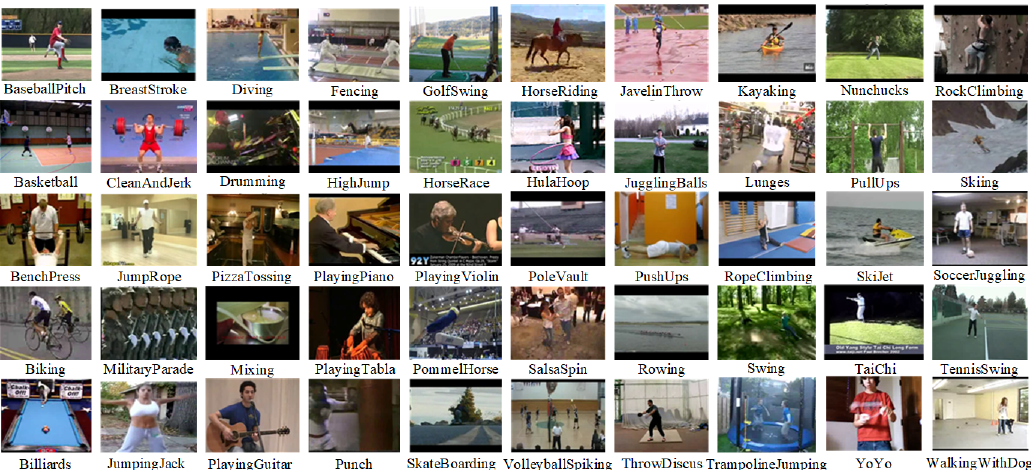
Figure 6. Example of the UCF50 dataset